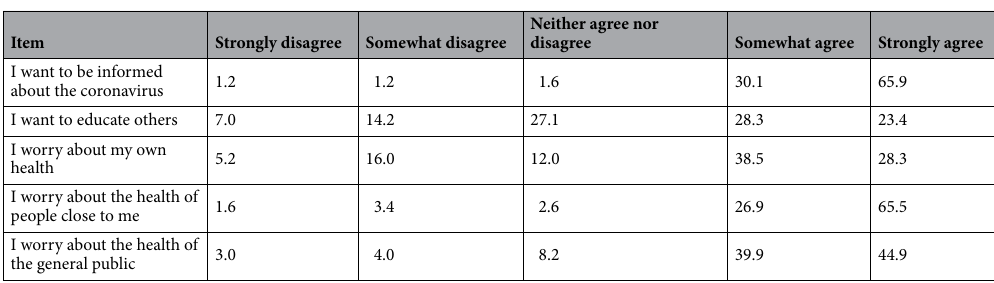
Table 5. Motivations for COVID-19-related information acquisition. Values represent percentages. N =